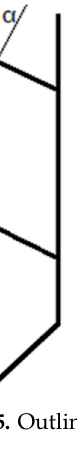
3.22 mm/h; 10:0.10 at. Zn; and 4:0.04 at. Zn.